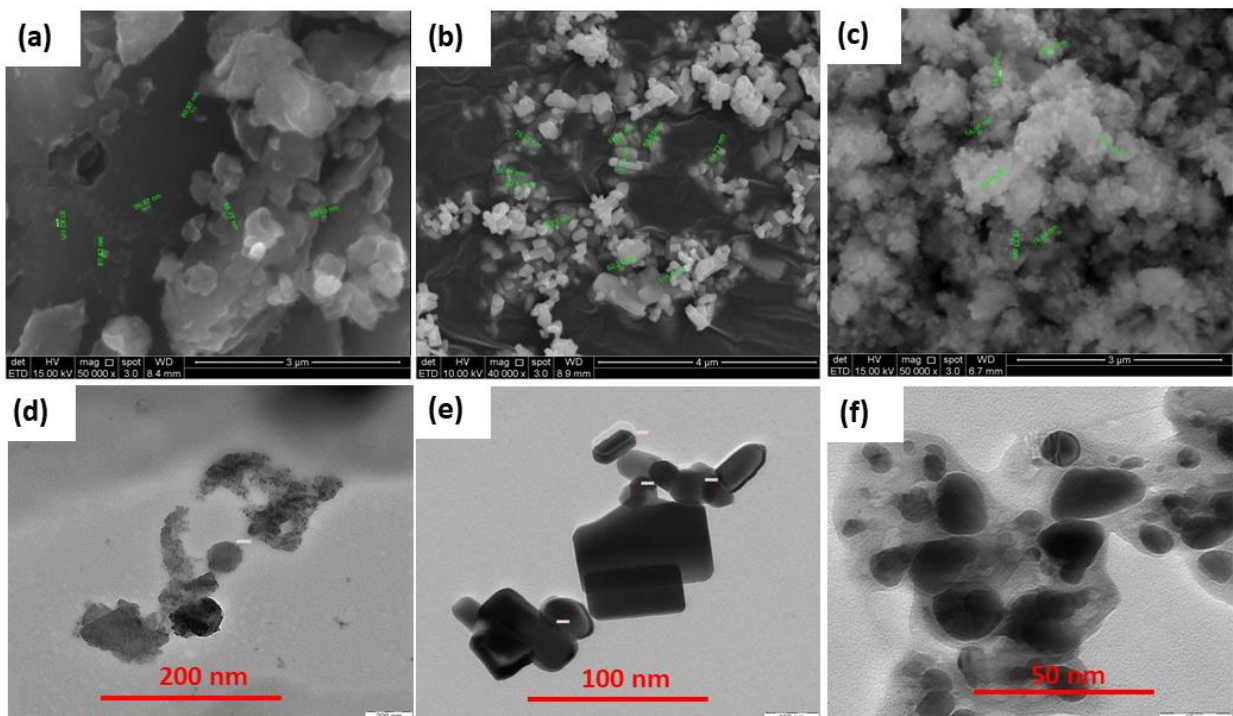
Figure 2. SEM images of ( a ) GO at 5 × 10 4 mag ( b ) ZnO at 4 × 10 4 mag, ( c ) GO-ZnO at 5 × 10 4 mag. TEM images of ( d ) GO ( e ) ZnO ( f ) GO-ZnO as-synthesized catalyst. Elemental analysis of the catalyst (GO) using energy-dispersive X-rays (EDX) is shown in Figure 3. GO contains around 74.52% carbon, 19.77% oxygen, 0.59% Cl, and a trace amount of Ti and K. In Figure 3 (GO-ZnO), the elemental analysis of GO-ZnO is shown by EDX; Zn is present at 39.94% by weight, O and C are available at 20.94% and 39.12% by weight, respectively.